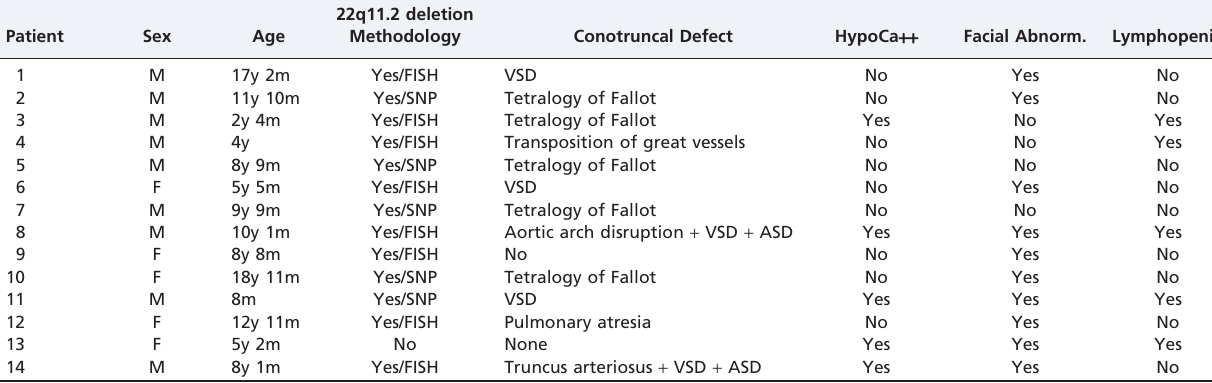
Table 1 - Diagnostic criteria in 14 patients with